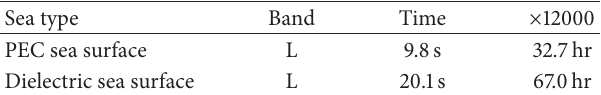
Table 3: Comparisons of CPU time of different types of underlying sea surface at our